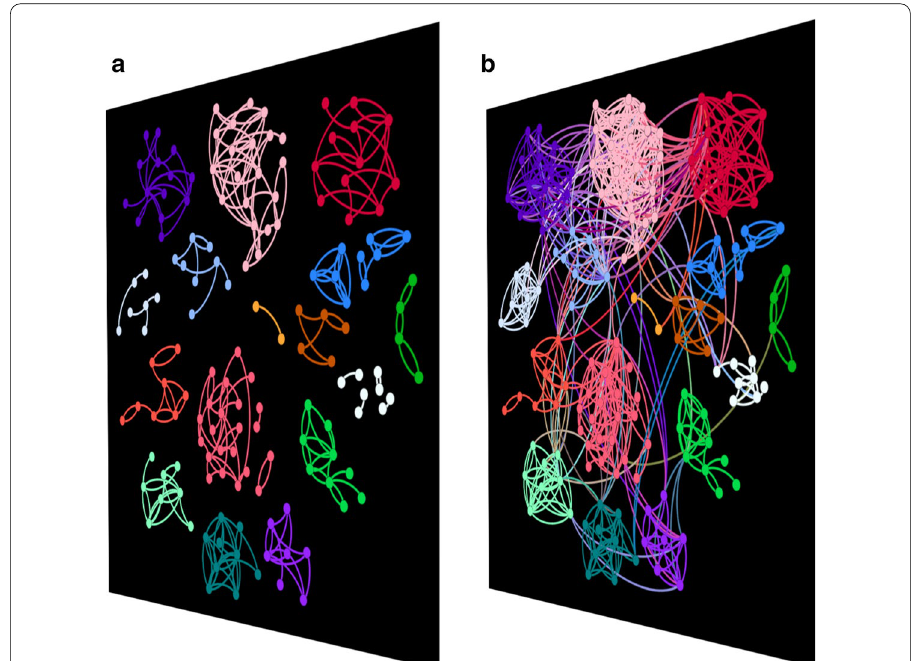
Fig. 1 Connections of respondents. a Connections in the information networks within firms. Colours represent firms. b LinkedIn connections added to advice network. The colour of inter-firm edges is set on a dyadic level as the interpolation of the nodes’ colours. LinkedIn connections cluster within firms, but a significant number of bridges connect the firms of the